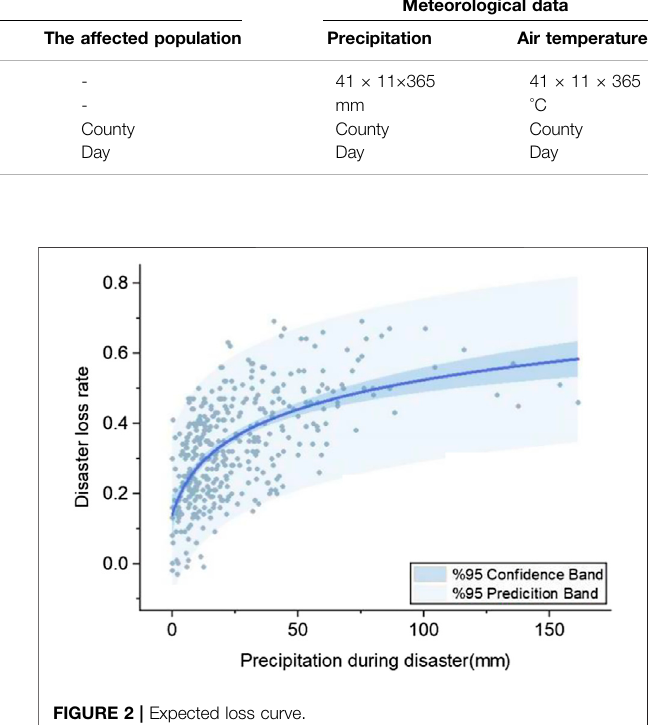
FIGURE 2 | Expected loss